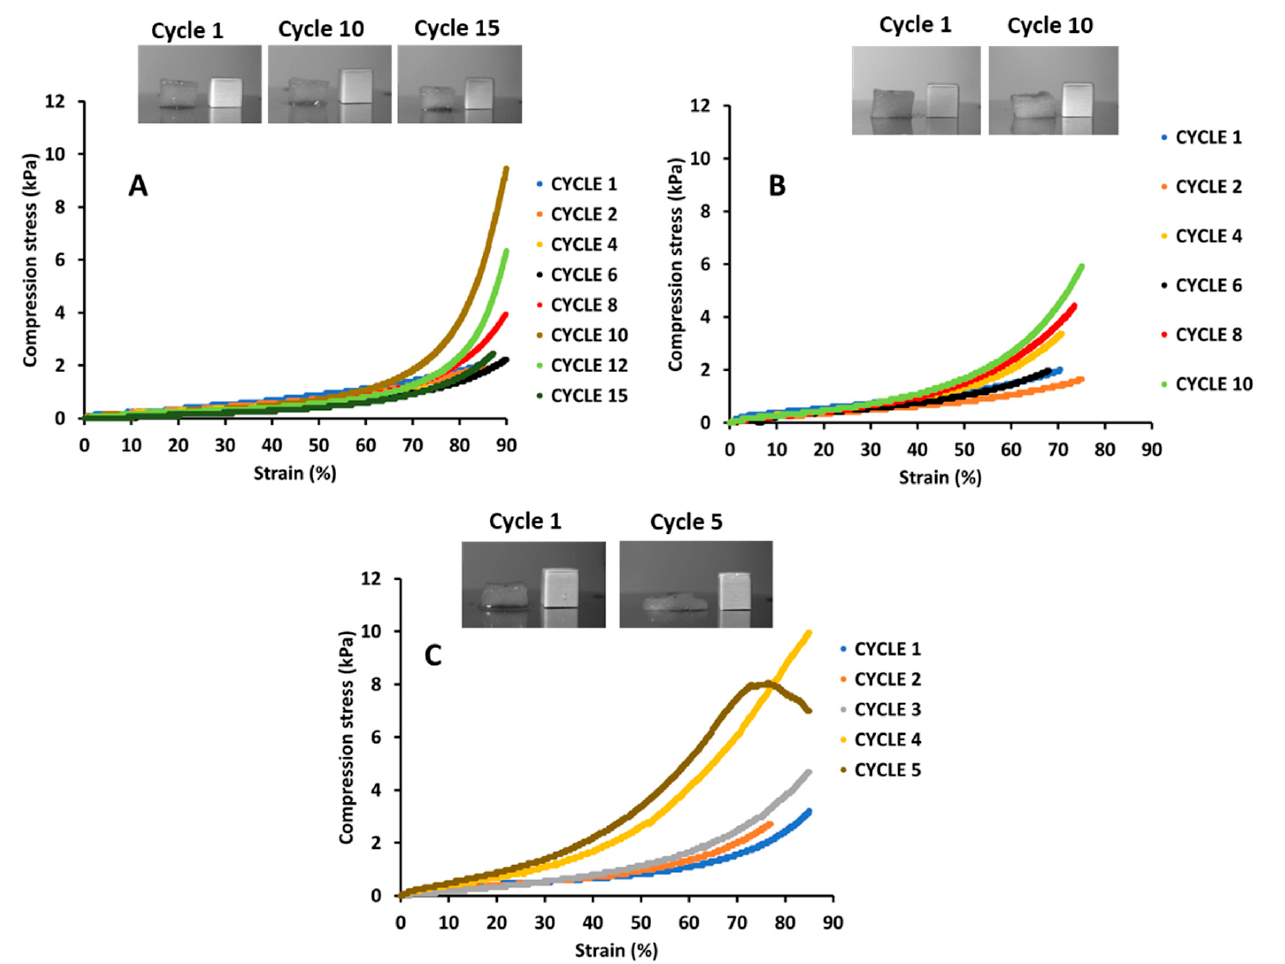
Figure 4. Compressive stress (kPa) vs. strain (%) of wet 2 wt % aerogels ( A ) CNF100 and ( B ) CNF95XG5 and ( C ) CNF60XG40.